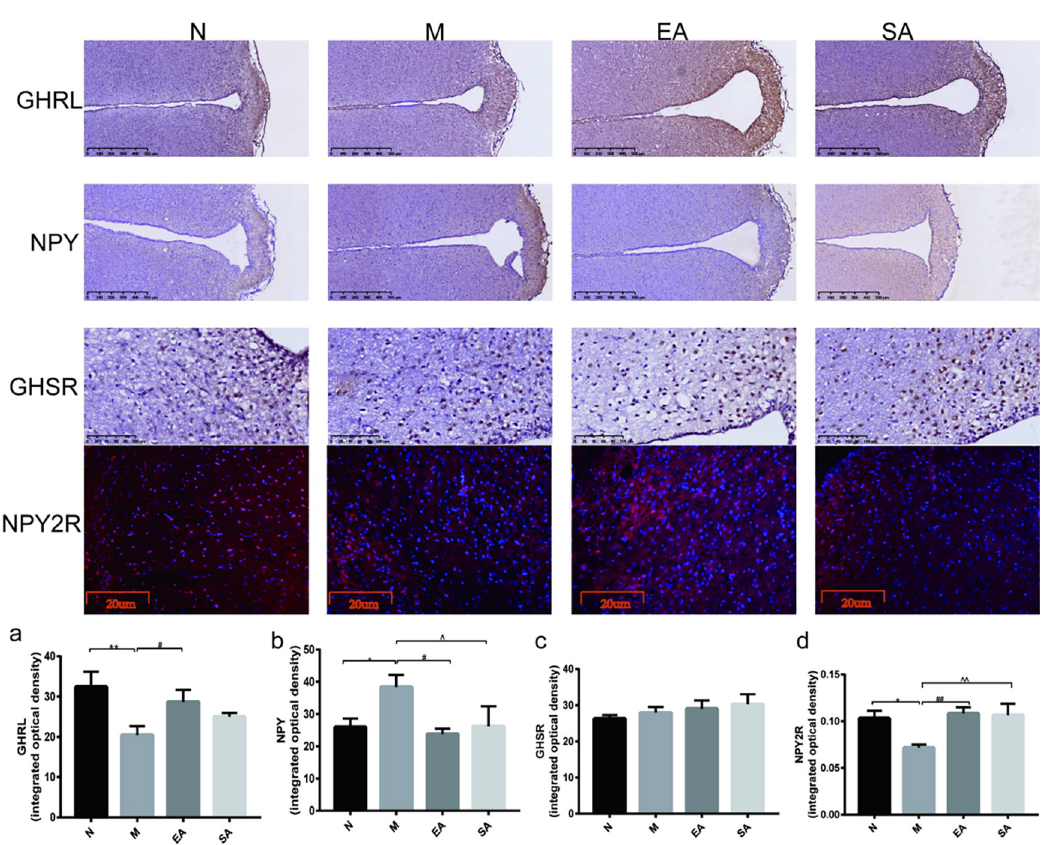
Fig 5. Expression of GHRL, NPY, NPY2R and GHSR in the arcuate nucleus (ARC) (a-d). N, normal group; M, model group; EA, electroacupuncture group; SA, sham acupuncture group; NPY, neuropeptide Y; GHRL, ghrelin; NPY2R, neuropeptide Y receptor; GHSR, ghrelin receptor; ARC, arcuate nucleus. The values are shown as mean ± SEM. N vs M, � P < 0.05, �� P < 0.01; EA vs M, # P < 0.05, # # P < 0.01; SA vs M, ^ P < 0.05, ^ ^ P <